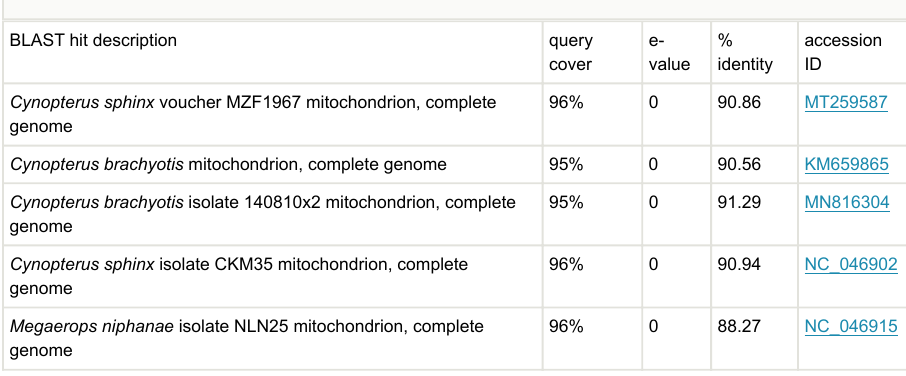
Top five NCBI-BLAST hits of the assembled mitogenome